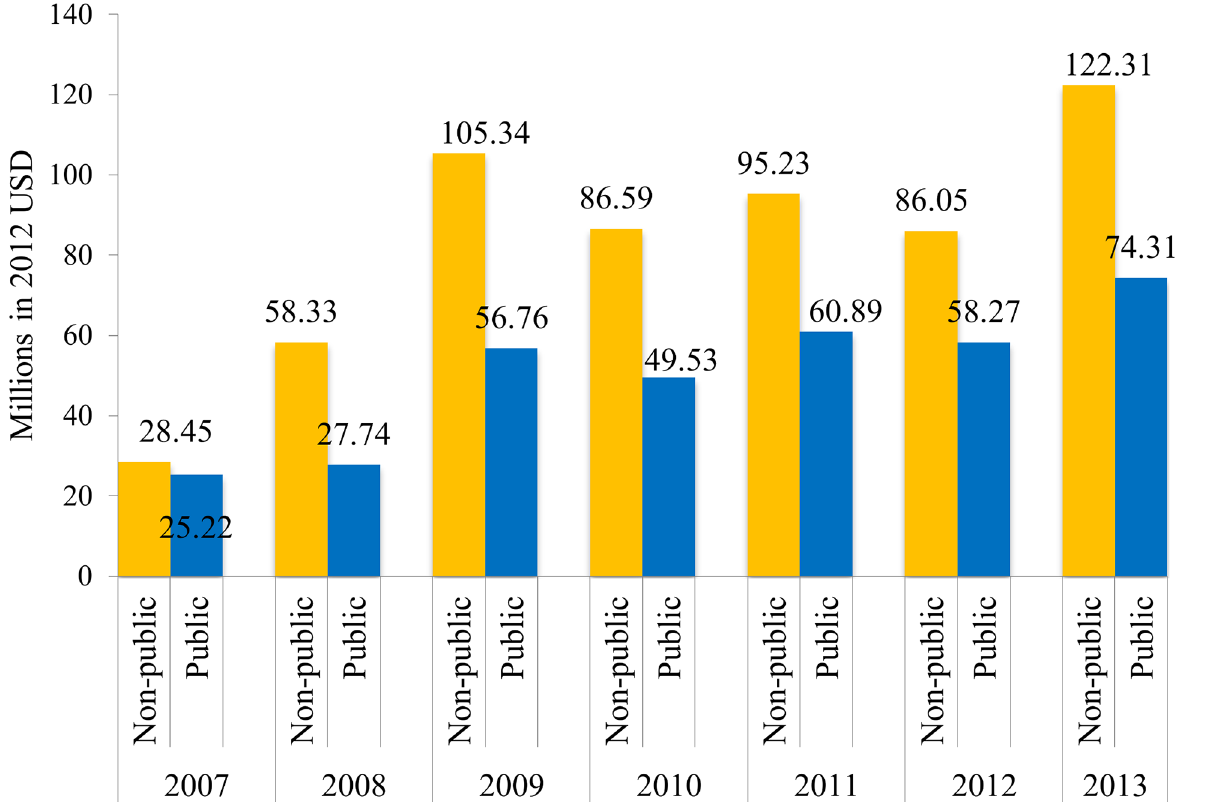
Fig 3. Annual DAMH by channel of delivery (assuming funding for projects with missing channels goes to public sector), 2007 – 2013.